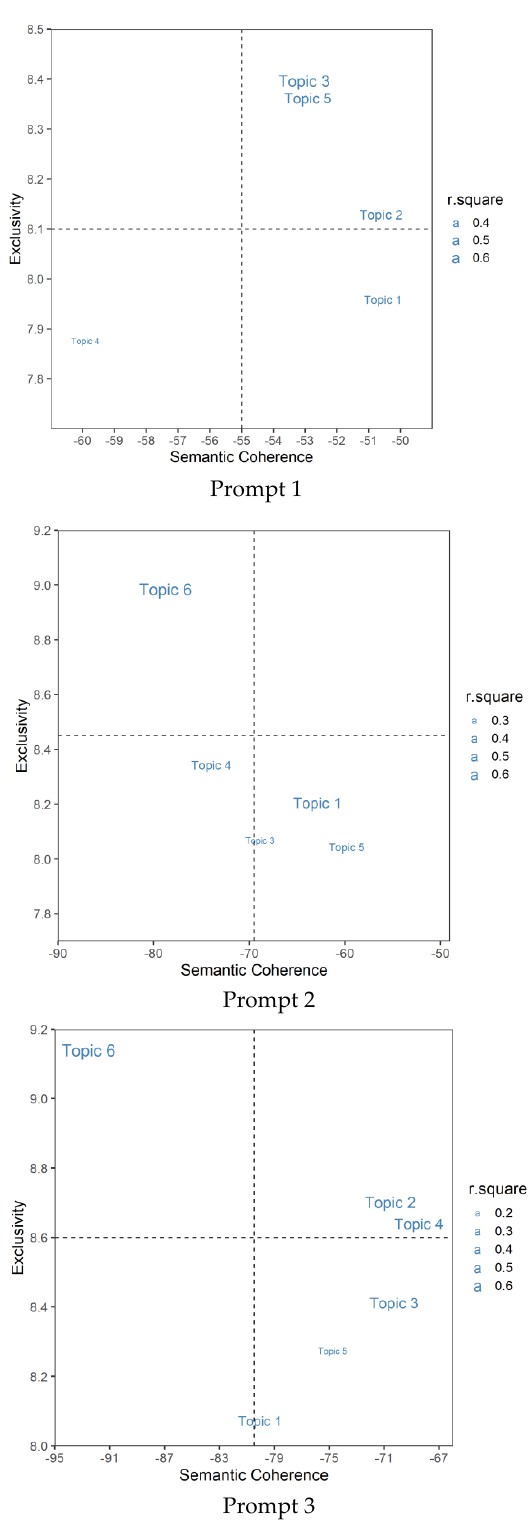
Figure 7. Topic quality and R-square. The quality of the topic is divided into four quadrants based on two diagnostic statistics (semantic coherence and exclusivity), and the size of the topic label reflects the R-square of the originality prediction for the given topic.